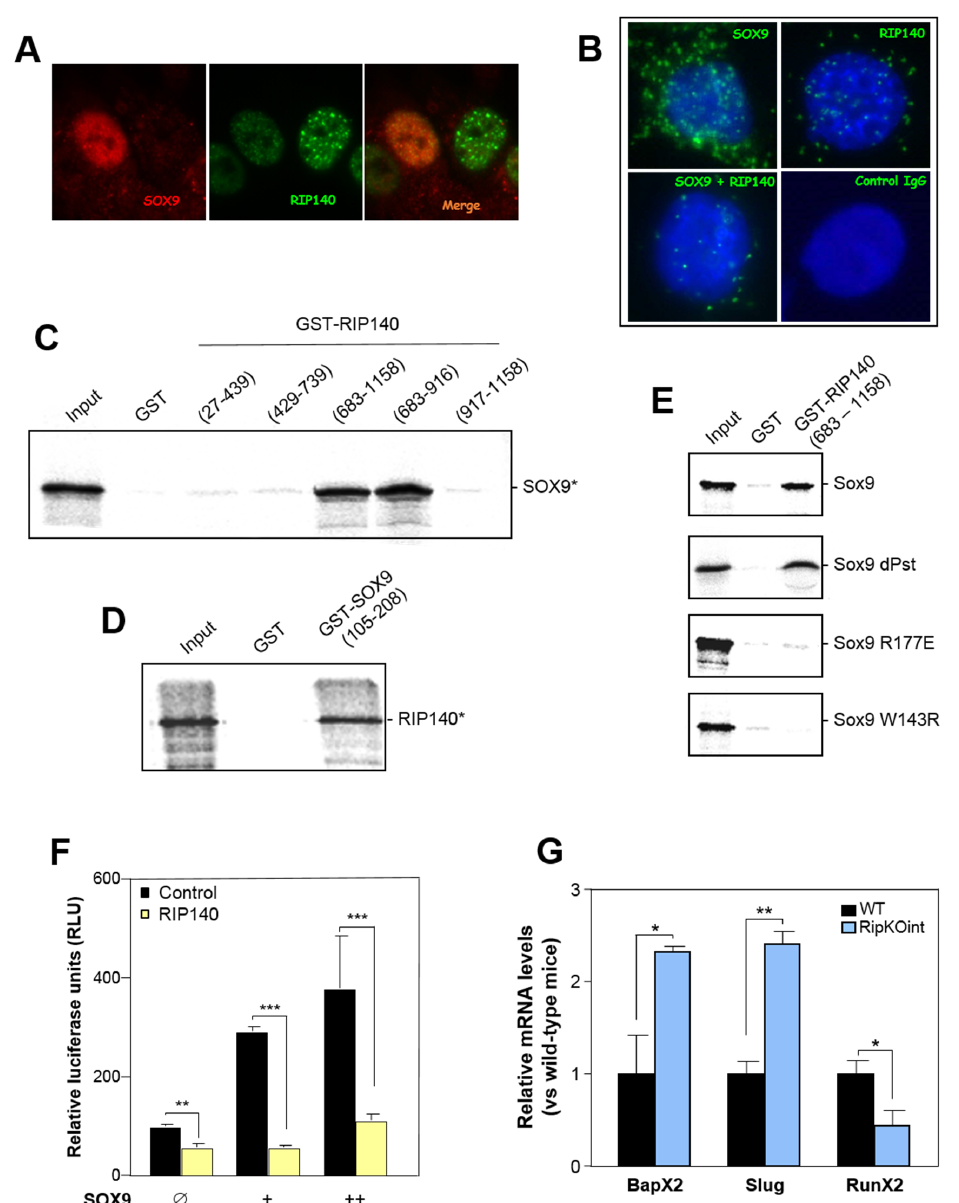
Figure 4. ( A ) Immunofluorescence of SOX9 and RIP140 in SW480 cells. Images show merged SOX9 (red) and RIP140 (green) detection. ( B ) In situ proximity ligation assays of SOX9 and RIP140, alone or in combination, in SW480 cells using primary anti-RIP140 and anti-SOX9 antibodies diluted in PBS–1%BSA. ( C ) GST pull-down assays were carried out using bacterially expressed GST, and GST-fused RIP140 fragments and 35 S-labeled SOX9. ( D ) Same as in ( C ) with GST-fused SOX9 fragment and 35 S-labeled RIP140. ( E ) GST pull-down assays were carried out as in ( C ) with GST and GST-fused SOX9 wild-type or mutant fragment and 35 S-labeled RIP140. ( F ) HCT116 cells were transfected with SOX9 response element reporter vector together or not with RIP140 expression plasmid and increasing doses of SOX9 expression vector. Relative luciferase activity was expressed as the mean ± S.D.; n = 3. ( G ) RT-qPCR analysis of Bapx2, Slug, and Runx2 in small intestines of WT and RipKO int mice. A Student t test was used for statistical analysis: * p < 0.05, ** p < 0.01, and *** p < 0.001.